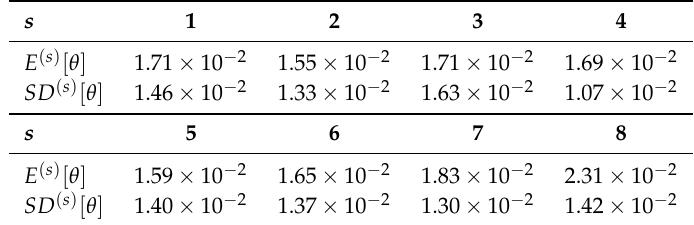
Table 1. The mean roll angle of the s th